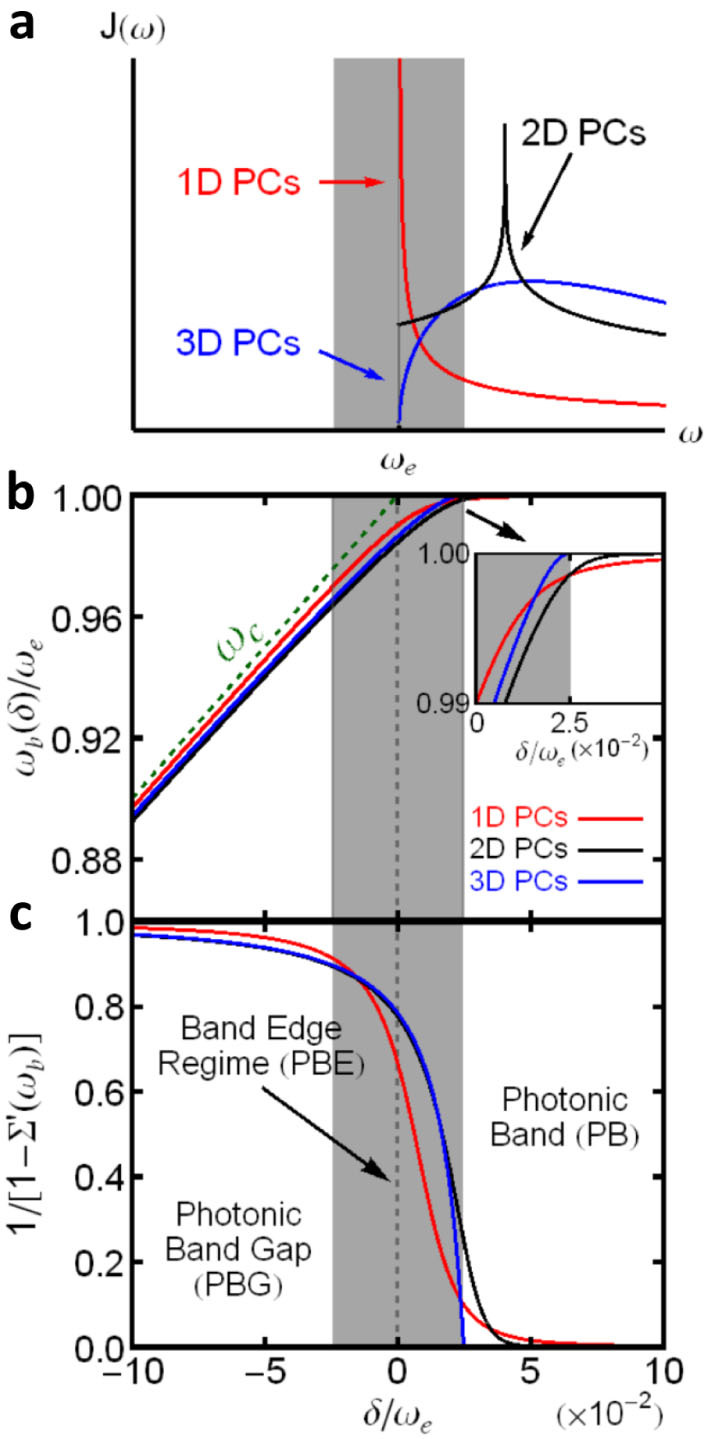
Band structures of photonic crystals and localized photon modes.(a) Spectral densities listed in Table 1 for different DOS of 1D, 2D and 3D PCs (with different colors) are plotted respectively in the vicinity of photonic band edge ωe; (b) The corresponding localized photon mode frequency ωb as a function of the detuning δ = ωc − ωe; and (c) The corresponding localized photon mode amplitudes, given in Eq. (2). The localized photon mode shows a crossover for 1D and 2D PCs, and a critical transition for 3D PCs when the cavity frequency ωc changes from the PBG region to the PB region. The parameters given in Table 1 take as follows: the coupling strengths for 1D, 2D and 3D PCs are C2/3 = 0.01ωe, η = 0.001ωe and χ = 0.014ωe, respectively. Experimentally, the typical photonic band edge frequency ωe ranges from a few GHz to a few tens GHz for most of 1D, 2D and 3D PCs3031, then the corresponding coupling strengths used in our calculations are ranged from a few MHz to a few hundreds MHz. The cutoff parameters Ωd ≈ 3.87ωe and ΩC = 0.1ωe; and the logarithmic divergence center ω0 = 1.04ωe.